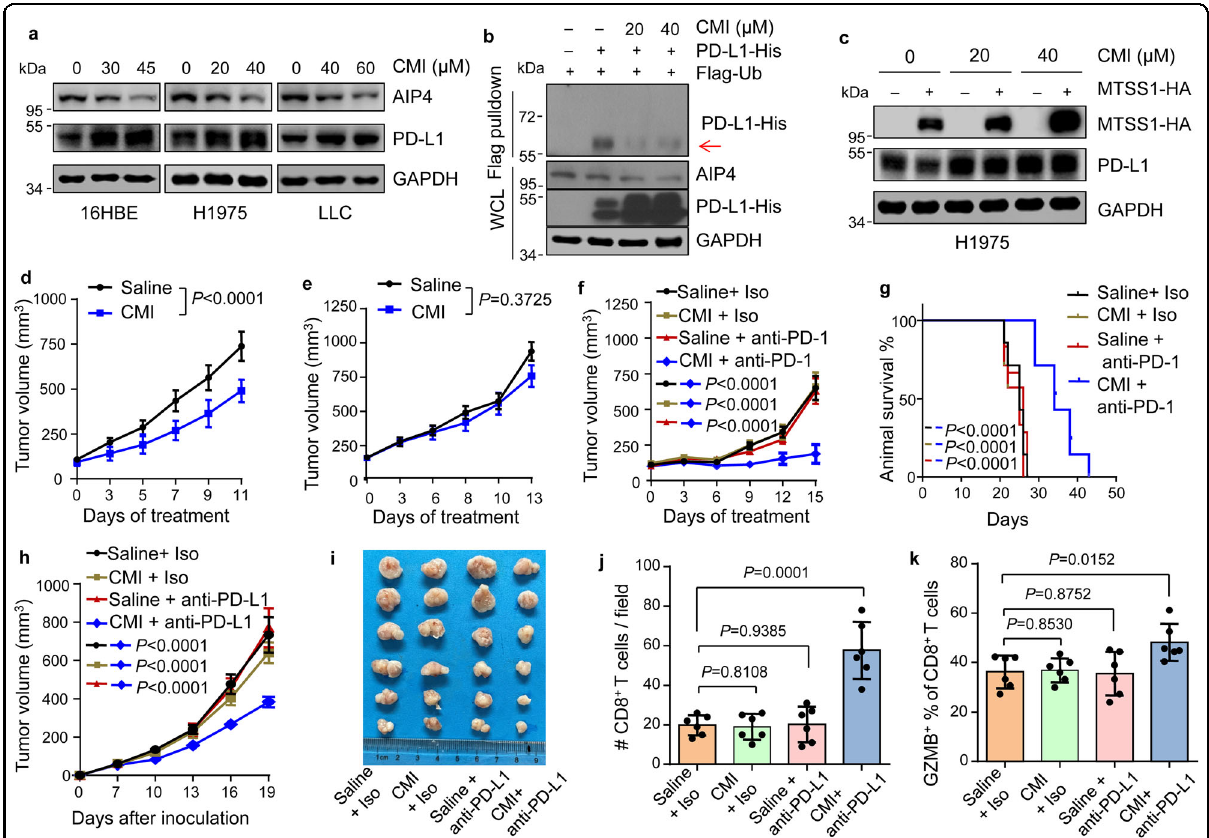
Fig. 6 Combinatory clomipramine and ICB treatment effectively suppress lung cancer. a Immunoblots of PD-L1 and AIP4 in the indicated cell lines treated with clomipramine (CMI) in various concentrations. b PD-L1 ubiquitination in 293 T after CMI treatment. Arrow points to monoubiquitinated PD-L1. c Immunoblots of H1975 with MTSS1 overexpression and/or CMI treatment. d , e Growth of LLC xenograft tumors in nude mice ( d , n = 8 and 9 for saline and CMI groups, respectively) and immunocompetent C57BL/6J mice ( e , n = 7 per group) with the treatment of CMI. Saline was used as treatment control. f , g Growth of LLC xenograft tumors in C57BL/6 J mice ( f , n = 7, 7, 6 and 7 respectively) and animal survival ( g ) with the treatment of CMI and/or anti-PD-1 (RMP1-14). Saline and antibody isotype (Iso) were used as treatment control. h – k Treatment of PMBC- humanized NSG mice bearing H1975 xenograft tumors with CMI and/or anti-PD-L1 (Atezolizumab). Shown are tumor growth ( h ), tumor images ( i ), quanti fi cation of immunohistochemistry staining of CD8 + T cells ( j ) and GZMB + CD8 + T cells ( k ) in the tumors ( n = 6 mice per group). Data are shown as means ± SEM ( d – f , h ) or means ± SD ( j , k ). P values were calculated by a two-tailed t -test ( j , k ), log-rank test ( g ), or two-way ANOVA ( d – f , h